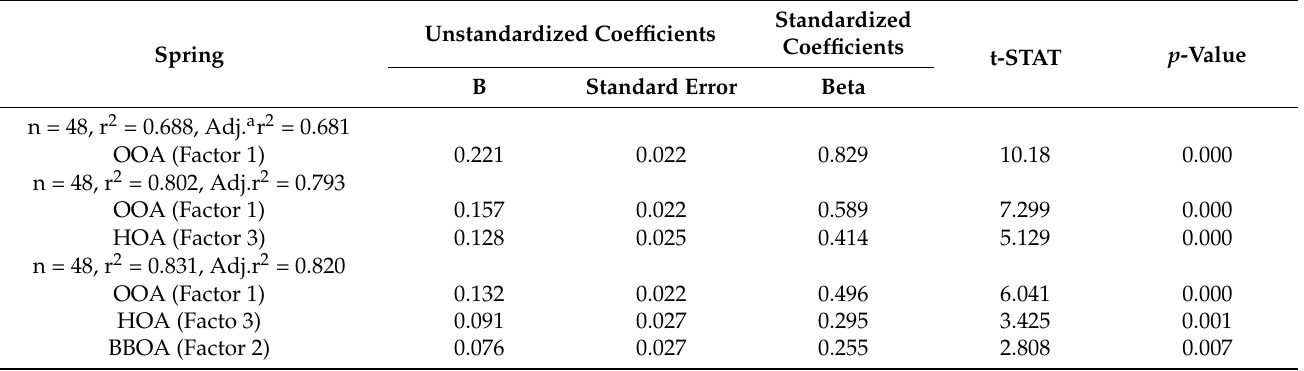
Table 4. Multiple linear regression between DTT v and individual source contribution resolved by PMF to WSOA in spring.